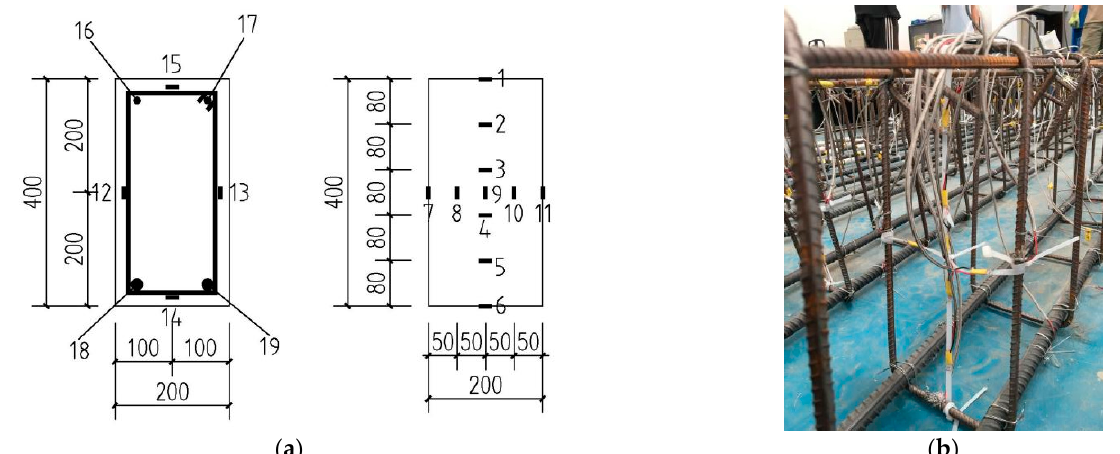
Figure 4. Arrangements of temperature measuring points: ( a ) Schematic diagram of measuring points; ( b ) real map of measuring points.